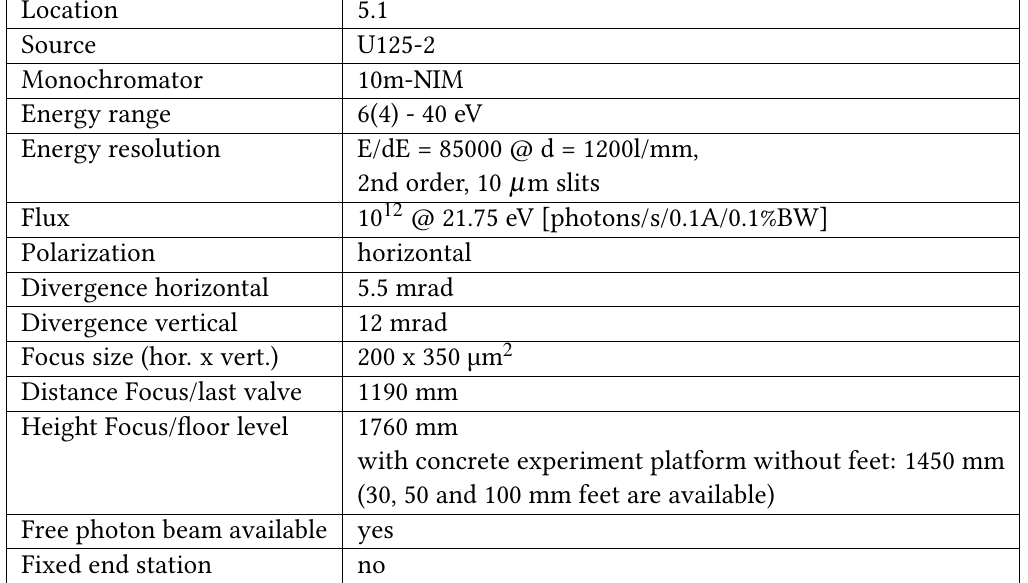
Table 3: Technical data for U125-2 NIM